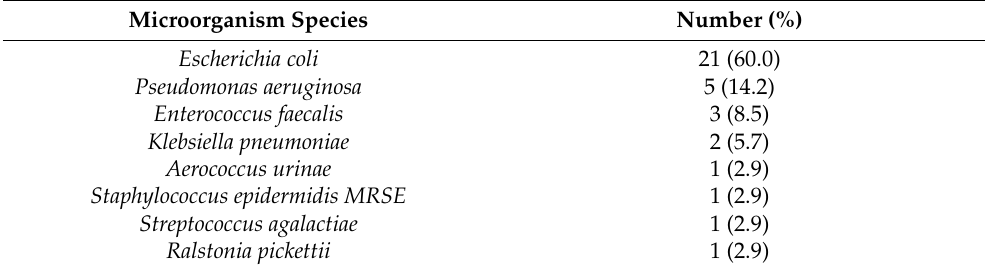
Table 2. Bacterial isolates from urine in patients with urinary tract infections.